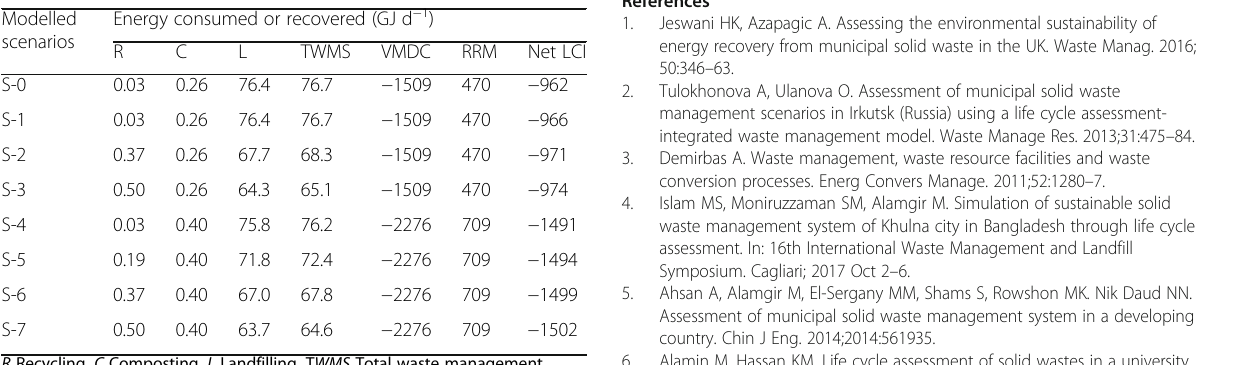
recovery of modelled scenarios in various waste manage- ment techniques. The maximum net energy recovering